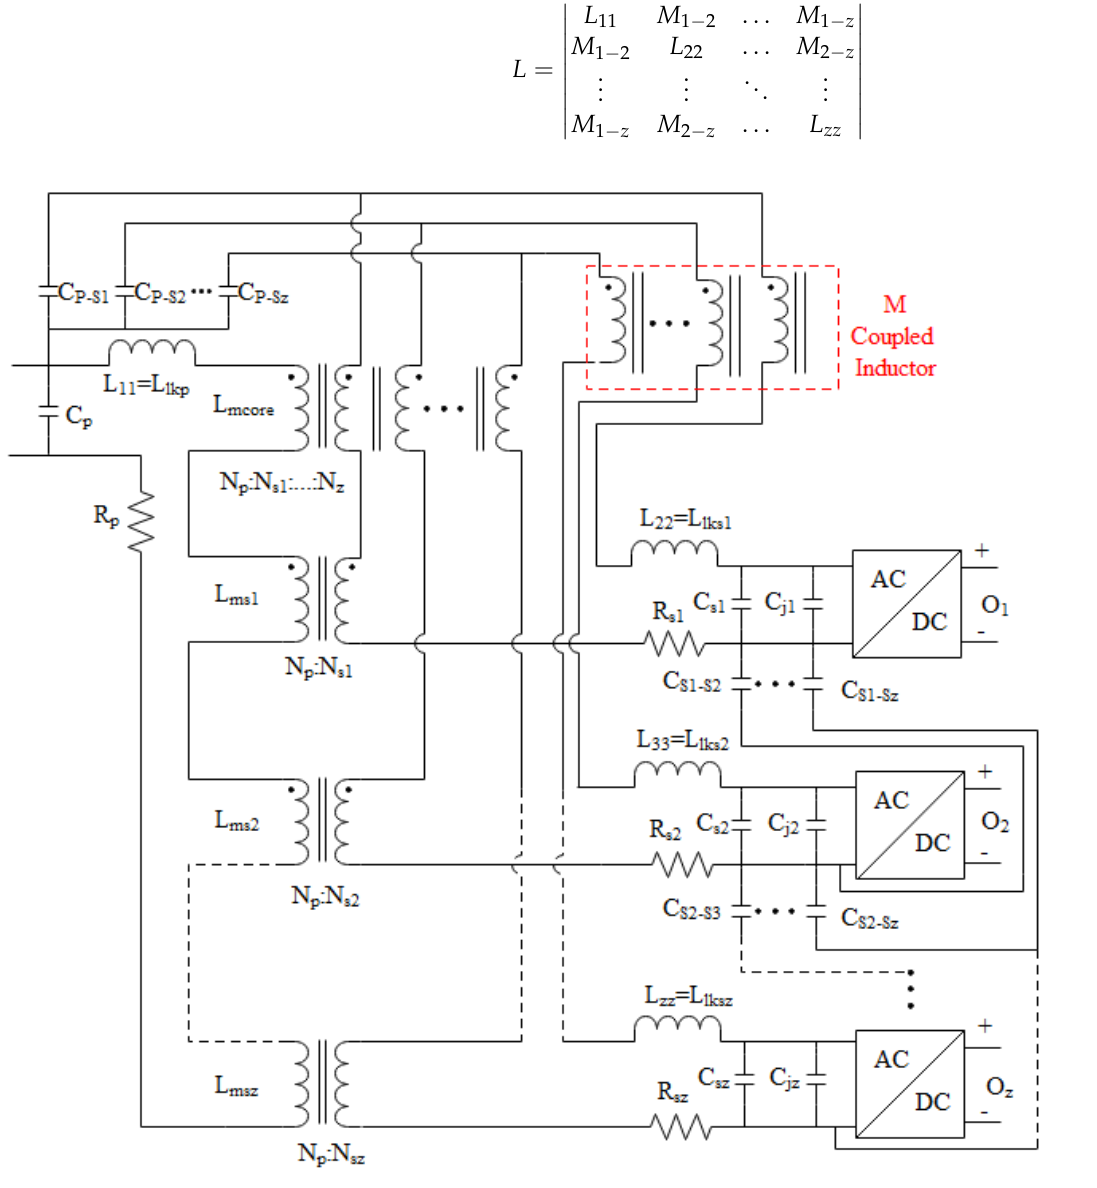
Figure 10. Multi ‐ winding